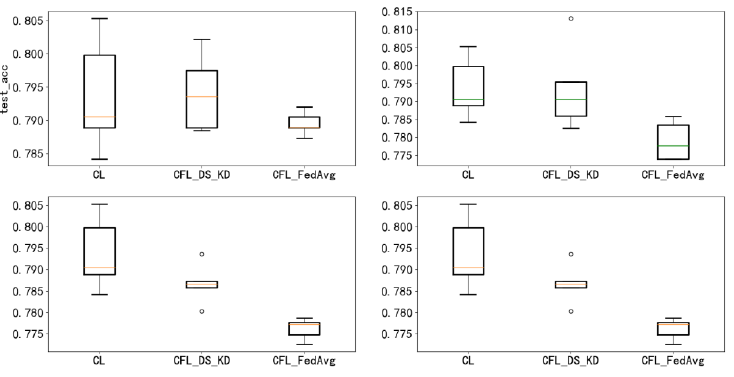
Figure 10. A performance comparison of the different methods under different MMD values.